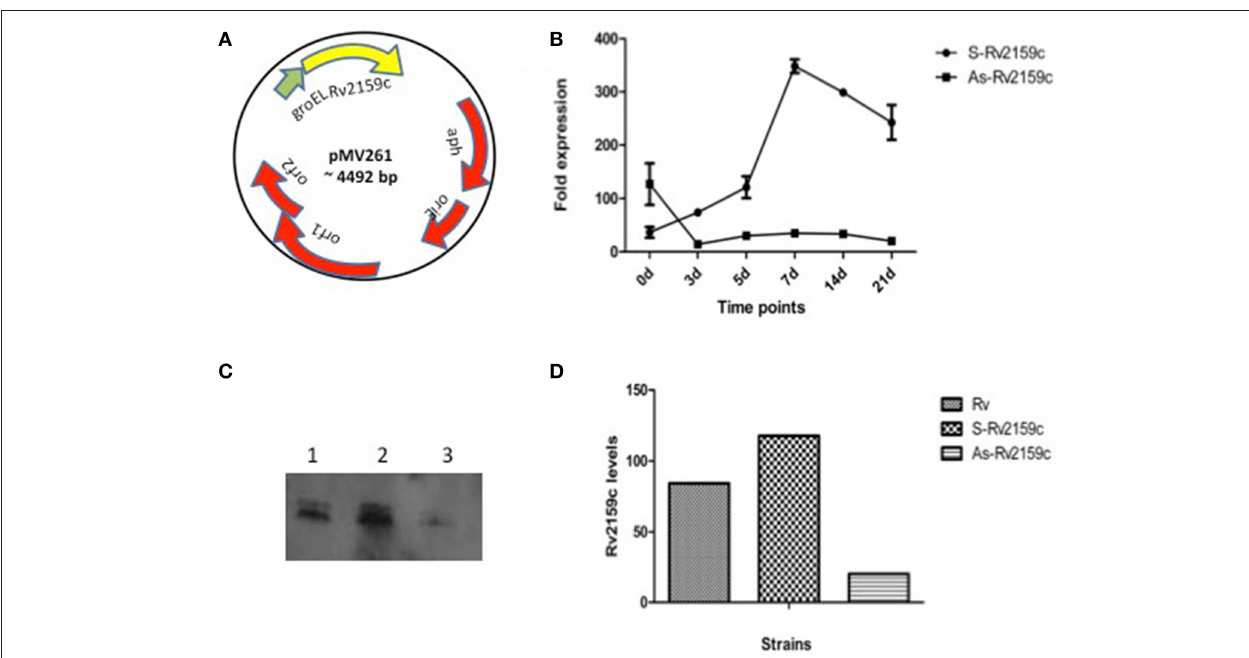
FIGURE 4 | Differential expression of Rv2159c. (A) pMV261 plasmid harboring Rv2159c in sense (S-Rv2159c) and antisense (As-Rv2159c) orientation. (B) Quantification of Rv2159c expression: Validation of Rv2159c differentially expressing constructs using quantitative real time PCR. Cell lysate of M. tuberculosis over-expressing (S-Rv2159c) and under-expressing (As-Rv2159c) Rv2159c gene was quantified at 0, 3, 5, 7, 14, and 21 days against the house keeping gene 16S rRNA. (C) FWB analysis for Rv2159c differentially expressing strains. Equal amount (50 µ g) of cytoplsmic lysates from 21 d cultures of Rv (lane 1), S-Rv2159c (lane 2) and As-Rv2159c (lane 3) strains were probed with bait protein, PknI and anti-His antibody. (D) Quantification of Rv2159c protein band from Rv, S-Rv2159c and As-Rv2159c strains using densitometer scanning.